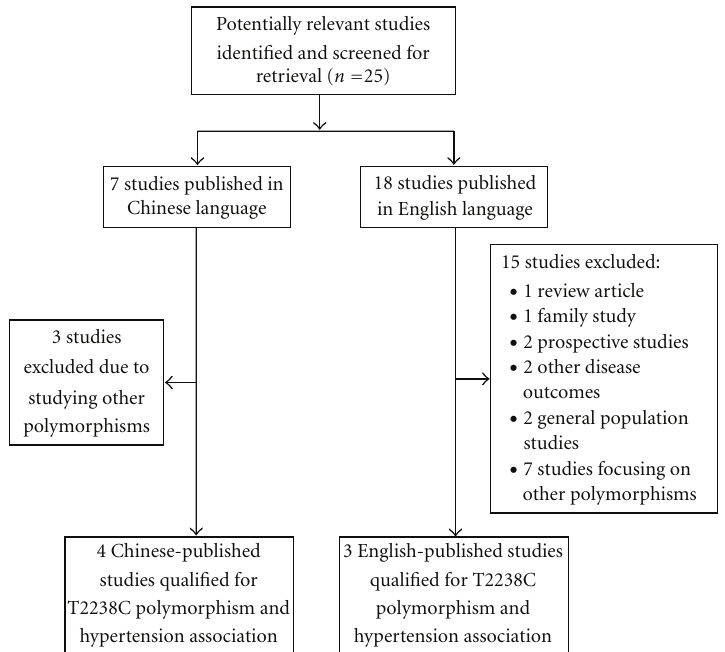
Figure 1: Flow diagram of search strategy and study